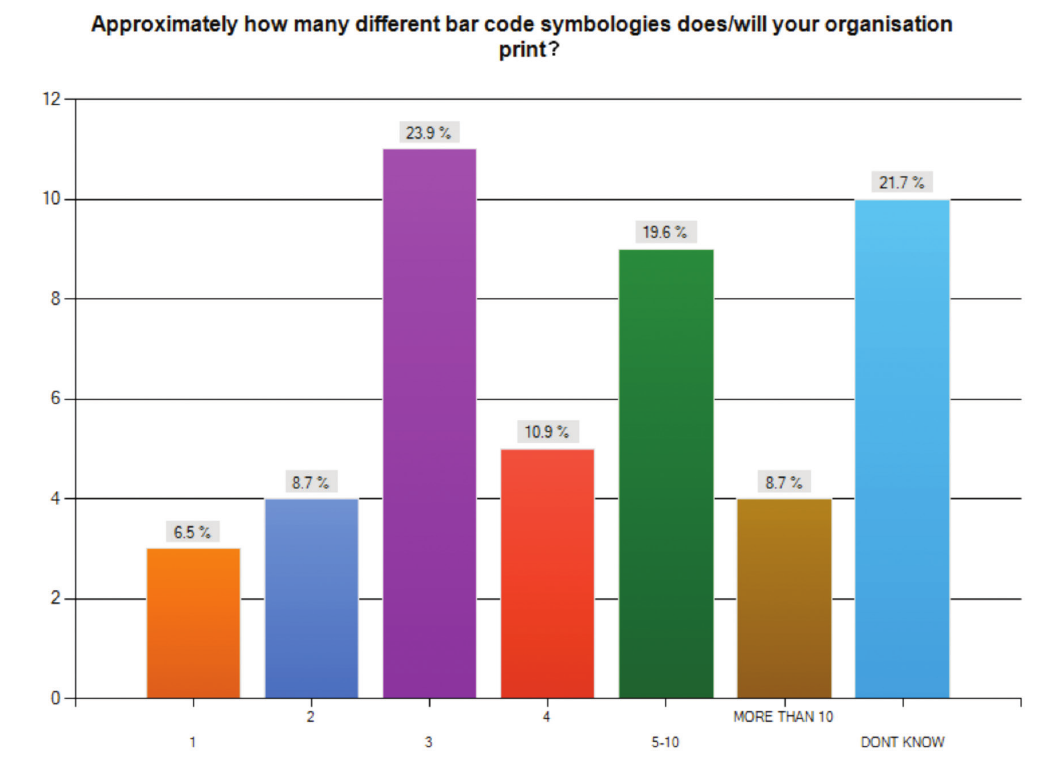
Figure 3: Different barcode